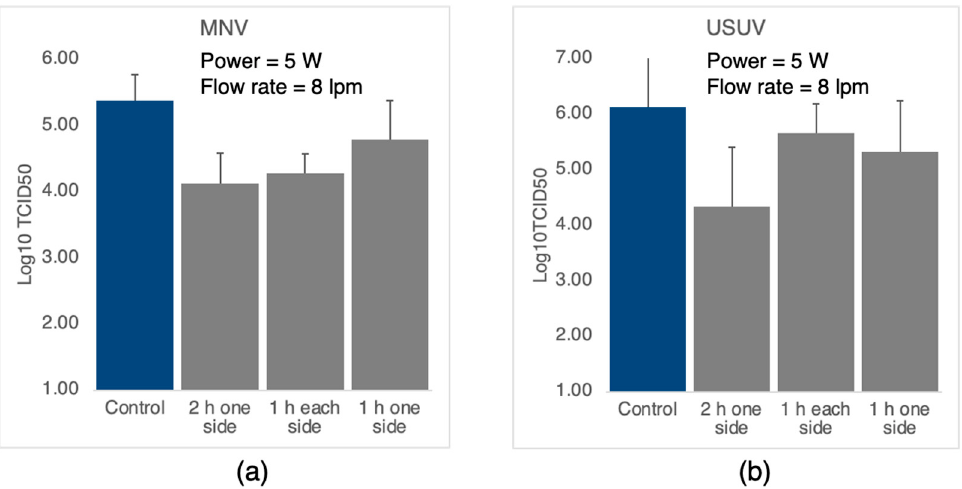
Figure 7. TCID50 assays for different coating times. ( a ) Cloths exposed to murine norovirus. ( b ) Cloths exposed to Usutu virus. The nanoparticle source conditions were power = 5 W, flow rate = 8 litres/min. The number of infectious virus particles has been reduced by a factor of 20 × for MNV and 60 × for USUV.